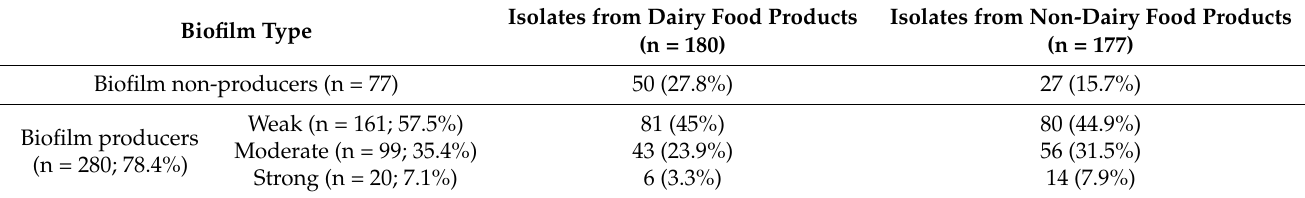
Table 3. Types of biofilm produced by bacteria isolated from different food sources (n =